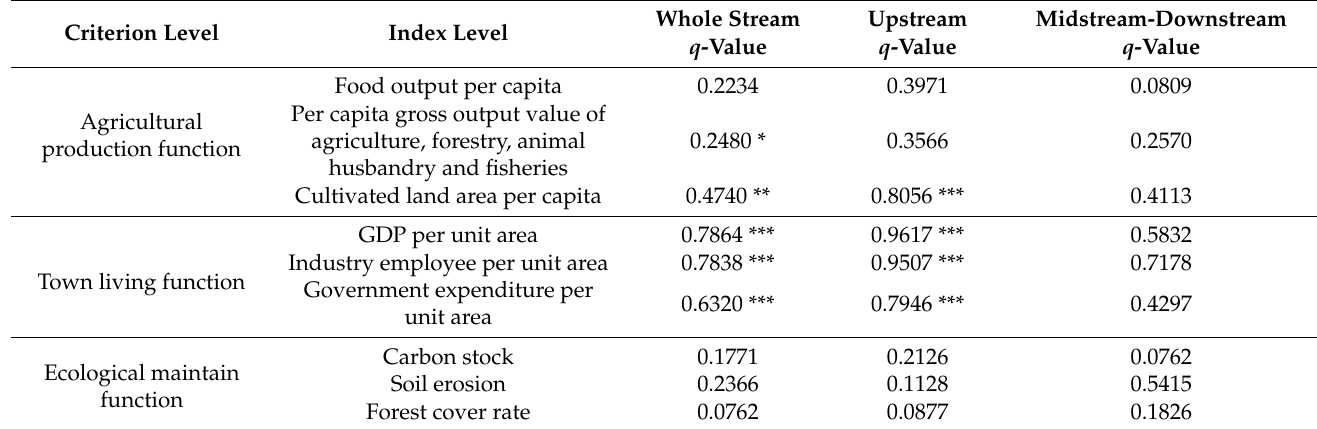
Table 5. The impact of LUMF factors on the internal mechanism of